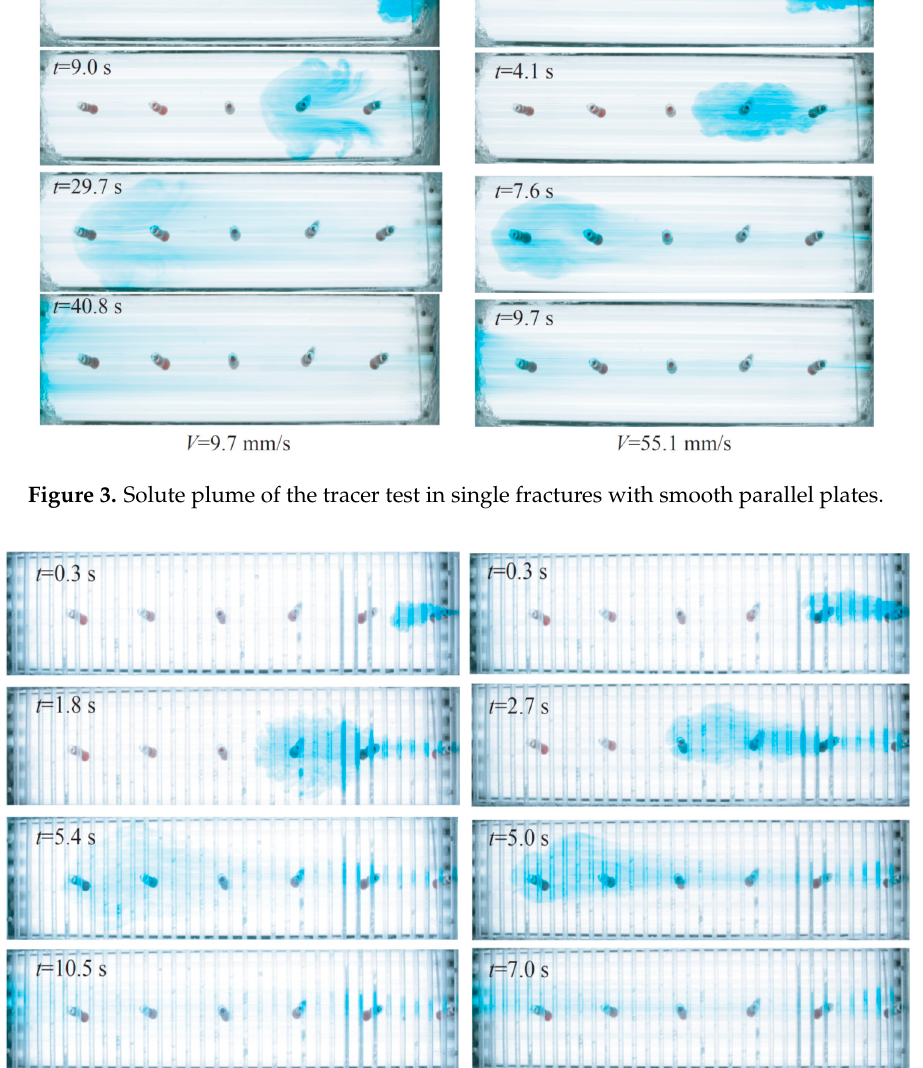
Figure 5. Solute plume of the tracer test in rough single fractures with trapezoidal roughness. A few observations can be made about Figure 3. For the smooth parallel plates shown in Figure 3, when flow velocity V was as small as 9.7 mm/s, the solute plume moved forward as a lump, but the color inside the plume for each point was not the same, indicating that the solute had not yet fully mixed. The front of the plume showed a typical Gaussian distribution. Lateral dispersion was also clearly visible and irregular movement of the solute with a long tail occurred. When the flow velocity V reached a relatively higher value of 55.1 mm/s, the front of the plume also showed a Gaussian distribution but the lateral dispersion was reduced. Similarly, with that for V of 9.7 mm/s, the concentration inside the plume showed apparent difference and a distinctive long tail also appeared in this case. Figure 4 showed the solute plume of Brilliant Blue FCF through a rough single fracture with trapezoidal roughness. The differences from that shown in Figure 3 were as follows: the front of the plume was irregular, rather than smooth, which was obviously caused by the heterogeneity of fracture wall roughness. Figure 4 also indicates that the solute concentration inside the plume was different and the solute migration rate was not the same for each point. In addition, retention of solute